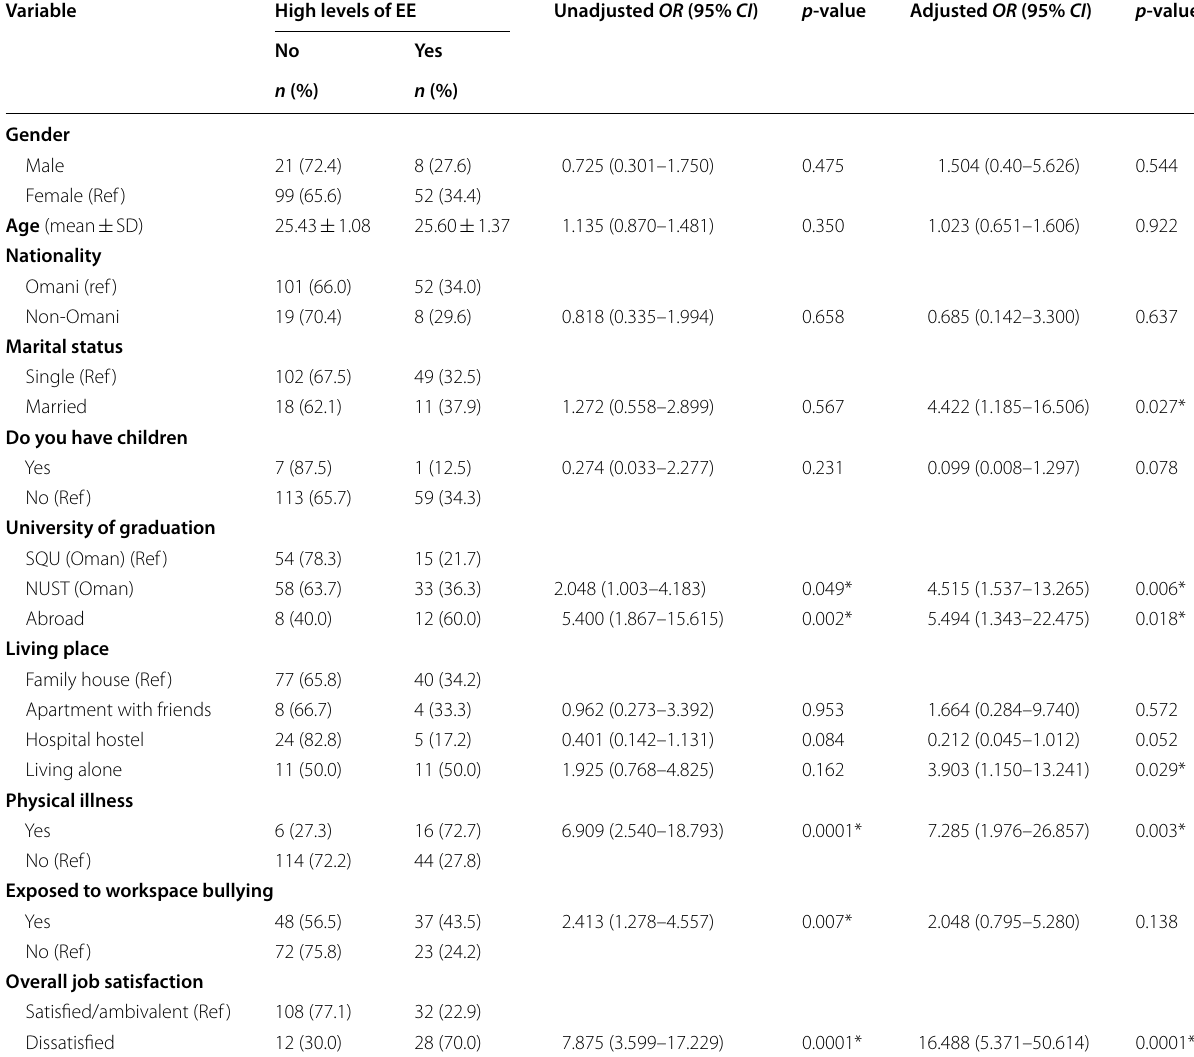
Table 2 The results of univariate and multivariate analysis with regard to the emotional exhaustion (EE) subscale and explanatory